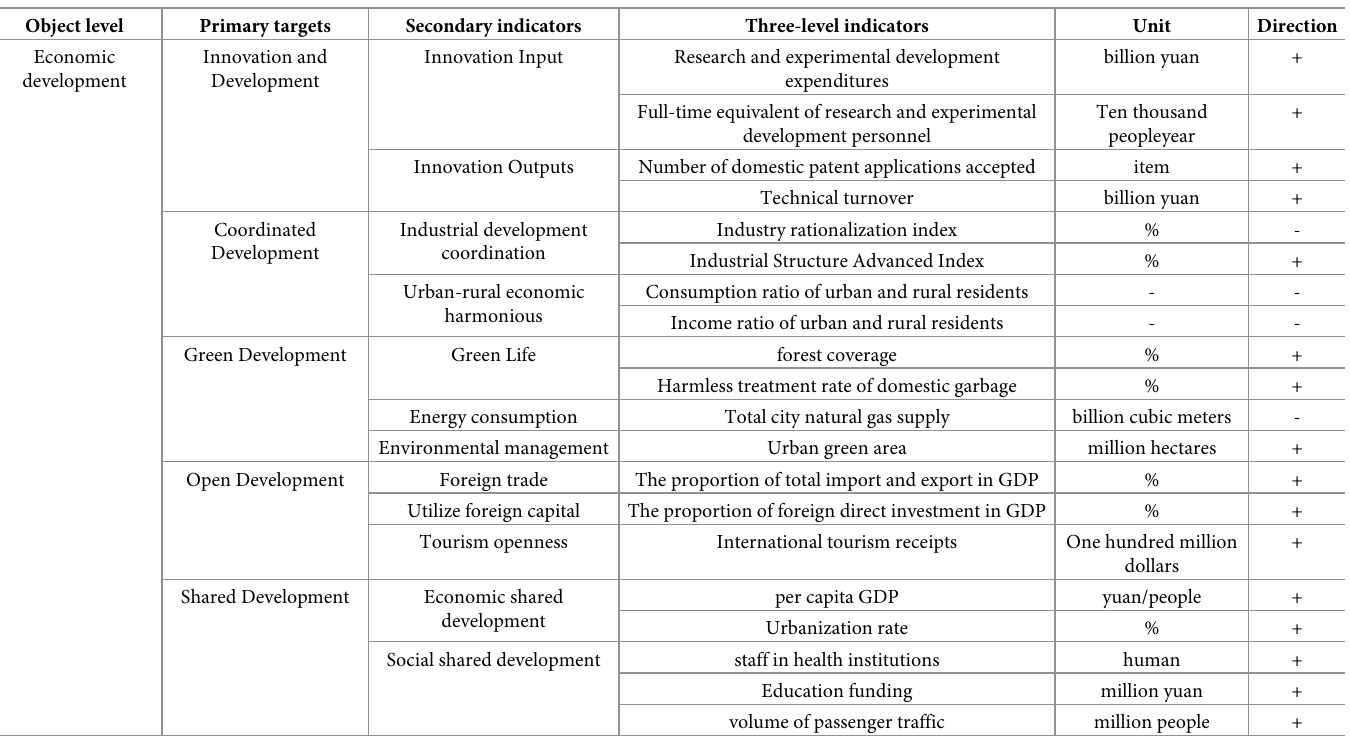
Table 1. Indicator system of economic development